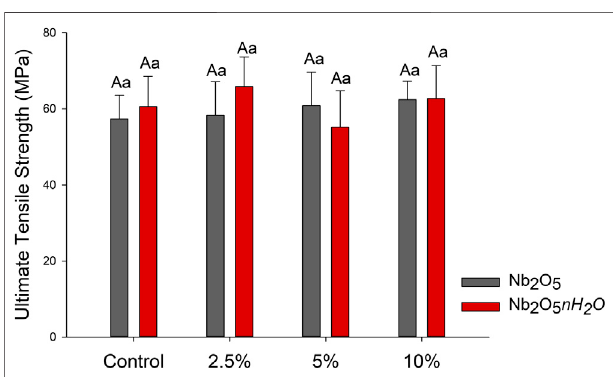
FIGURE 2 | Mean and standard deviation values of the ultimate tensile strength (UTS) of the dental adhesives in MPa. Different capital letters indicate a statistically signi fi cant difference among the concentrations (0, 2.5, 5, and 10 wt%) for the same type of fi ller (Nb 2 O 5 or Nb 2 O 5 . n H 2 O) ( p < 0.05). Different lowercase letters indicate a statistically signi fi cant difference within the same concentration(0, 2.5,5,or10 wt%)comparingthedifferenttypes